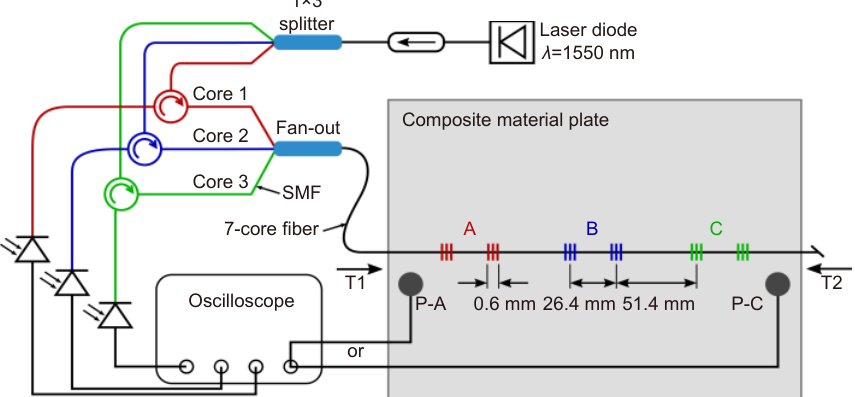
Fig. 10 | Schematic of an experimental setup for detecting AE in a PCM plate using FBG-FPIs (A, B, and C) written in different cores of the MCF.